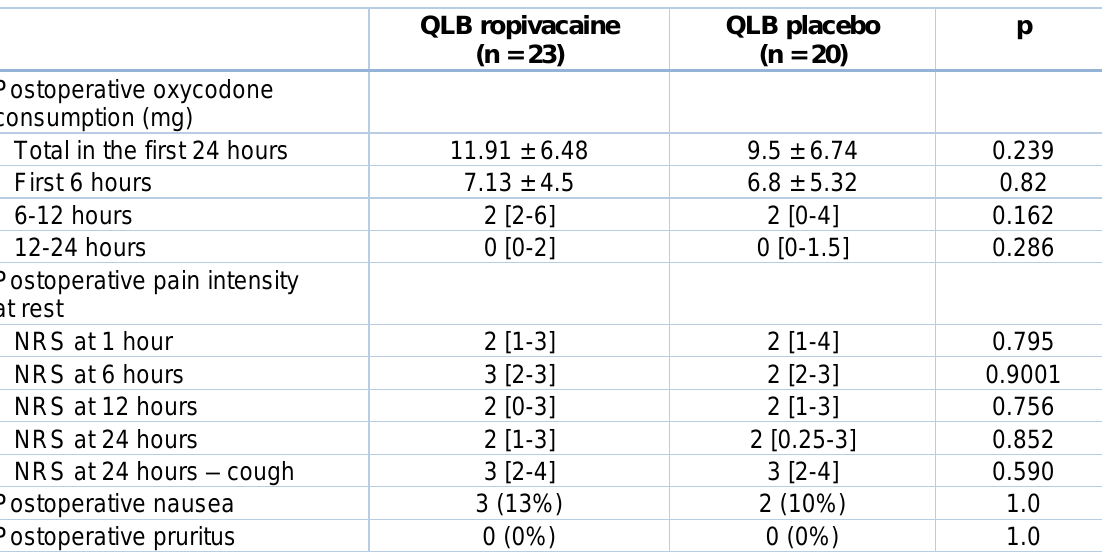
Table 2: Postoperative